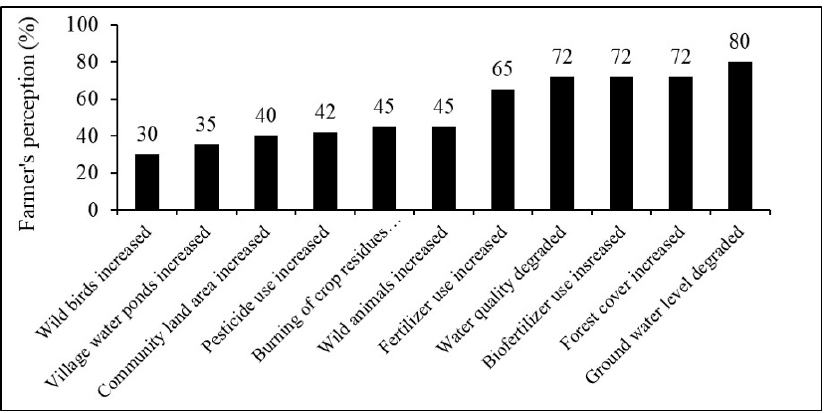
Figure 6. Farmers’ perceptions on different indicators of agroecosystem.